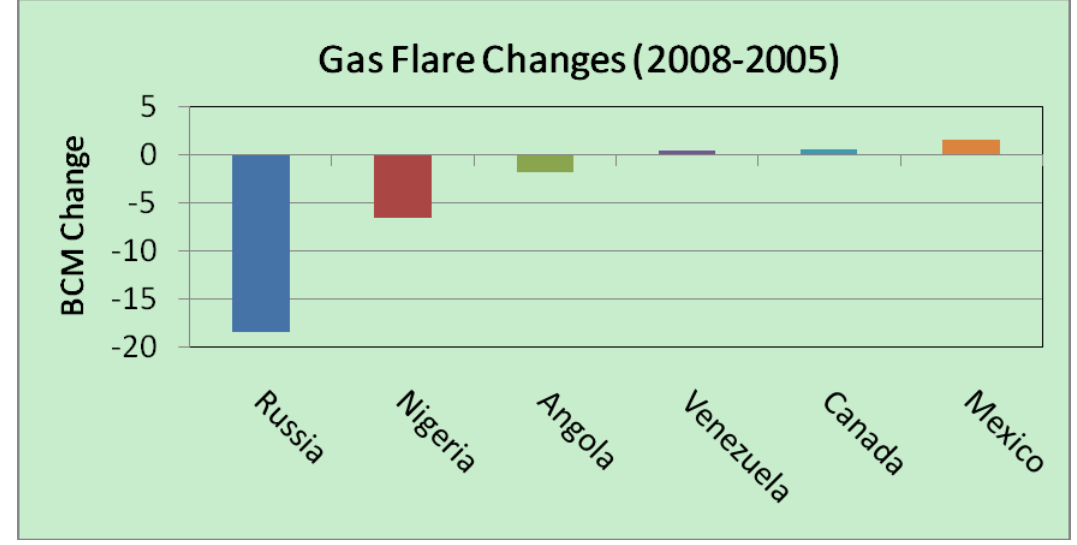
Figure 15. Comparison of the change in flaring from 2005 to 2008 for the top three countries showing decline (Russia, Nigeria and Angola) versus the three countries with the most increase in flaring over the same time period (Venezuela, Canada, and Mexico). Russia led in flaring reduction with a decline of 18 BCM. The total decline for Russia, Nigeria and Angola (−26 BCM) was ten times more than the increase in flaring for Venezuela, Canada and Mexico (2.6